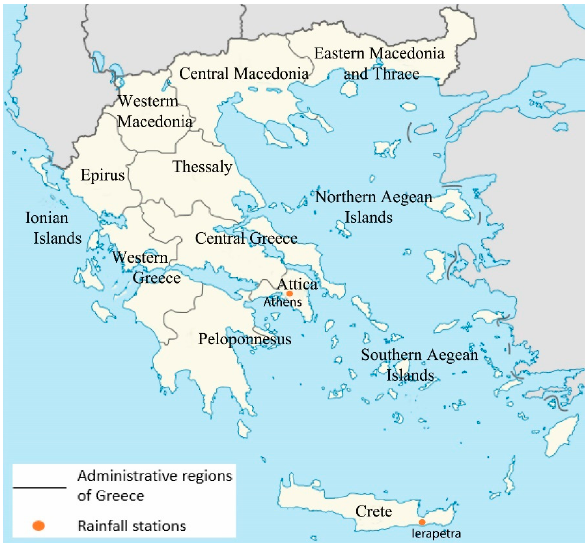
Figure 2. Rainfall stations in the study areas of Ierapetra (Crete, Greece) and Athens (Attica,